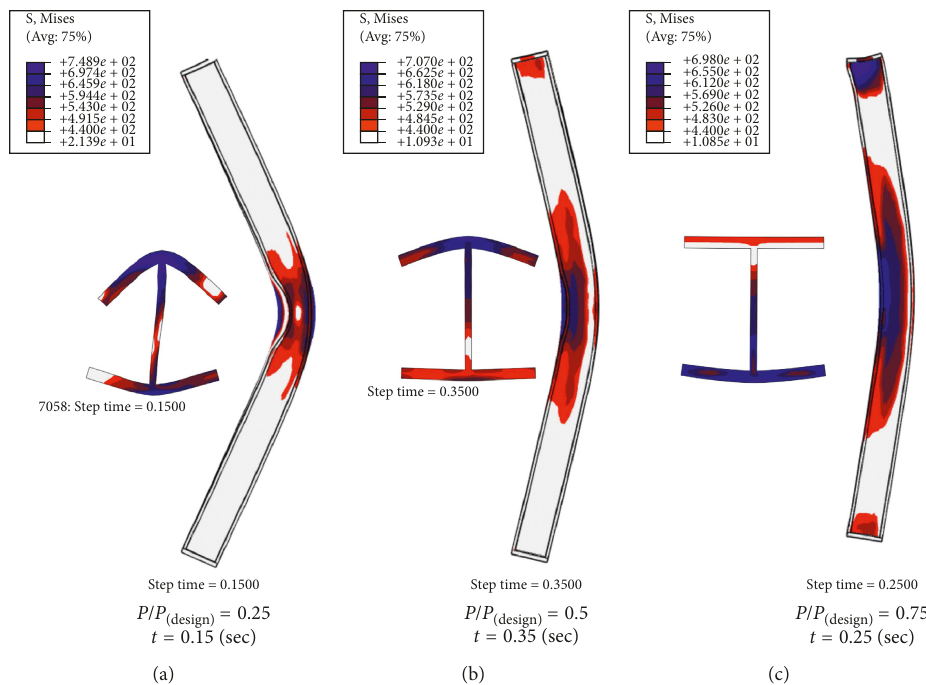
Figure 23: Deformation shape and plastic hinge locations of simply supported steel column W200